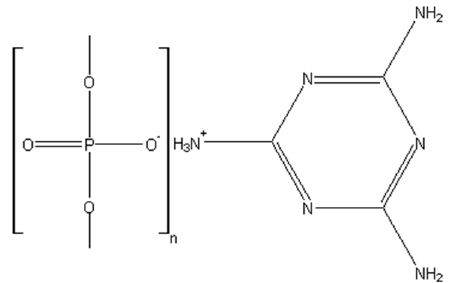
Table 1. Chemical structure of POSS nanoparticles.